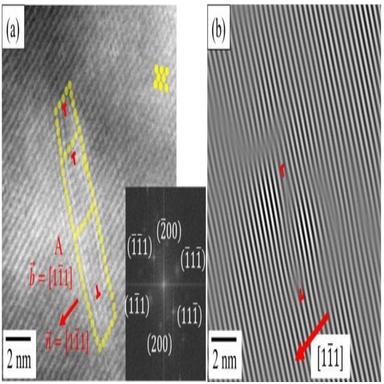
(a) On-zone atomic resolution STEM-HAADF image of a dislocation loop obtained using zone with the FFT pattern at inset; (b) corresponding inverse FFT image from the (11¯1) and (1¯11¯) spots.